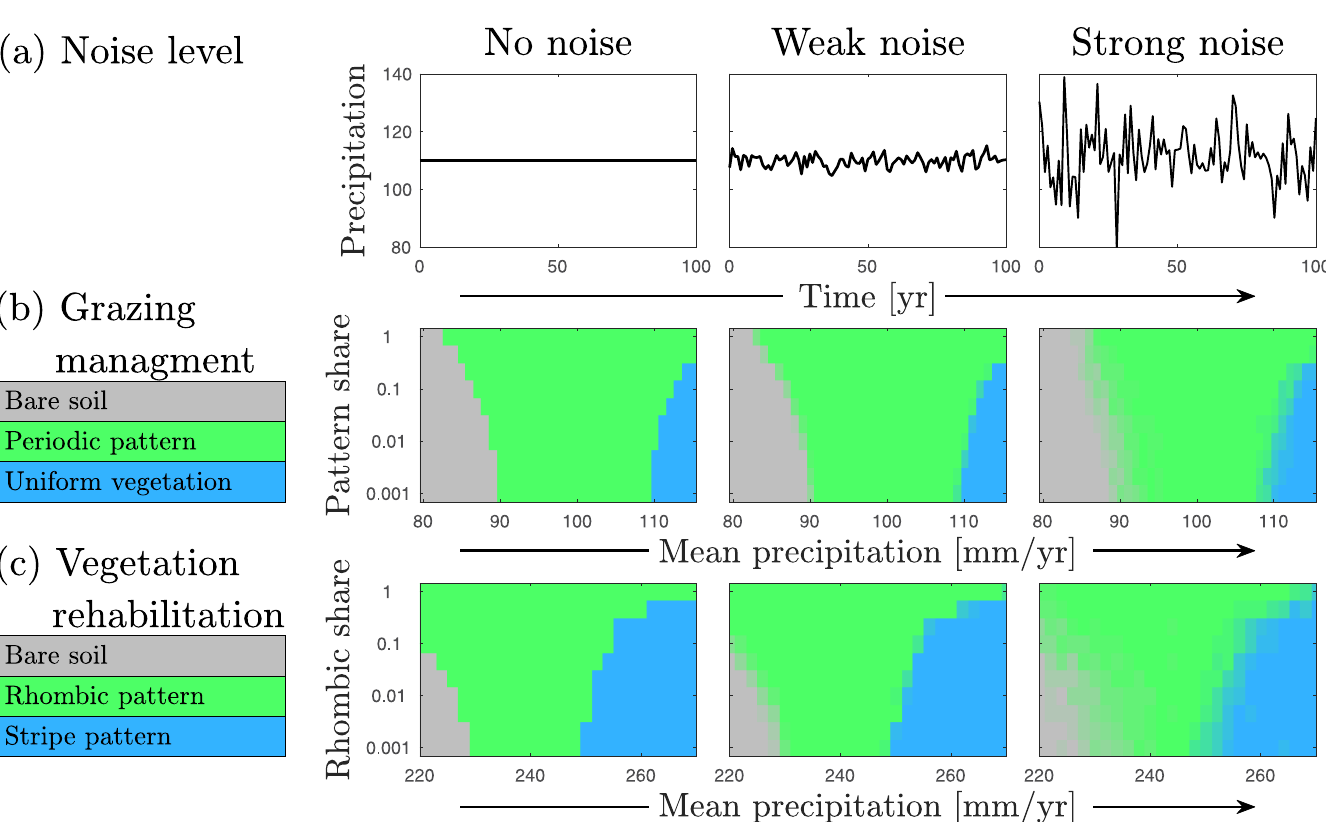
Fig 5. Responses to precipitation downshifts under stochastic precipitation and different initial conditions of mixed vegetation states. Left, middle and right columns correspond to negligible, weak and strong precipitation fluctuations, respectively. (a) Demonstration of noise level. (b) Asymptotic states (see color legend) for the grazing management system, where initial conditions consist of increasing portions of periodic pattern in uniform vegetation (pattern share). (c) Asymptotic states for the vegetation rehabilitation system, where initial conditions consist of increasing portions of rhombic pattern in stripe pattern (rhombic share). Each pixel in the parameter plane (mean precipitation—share) shows the asymptotic state obtained from averaging over 20 simulations with a unique randomization of temporal noise from a Gamma distribution per simulation, where the initial conditions correspond to mixtures of states calculated at P = 115[mm/yr] ( P = 260[mm/yr]) for middle (bottom) row. Note that this vertical axis is